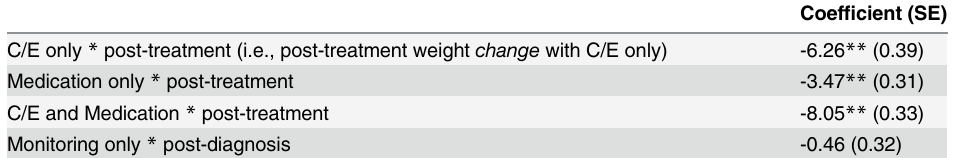
Table 3. Effect of Counseling/Education (C/E) on Weight